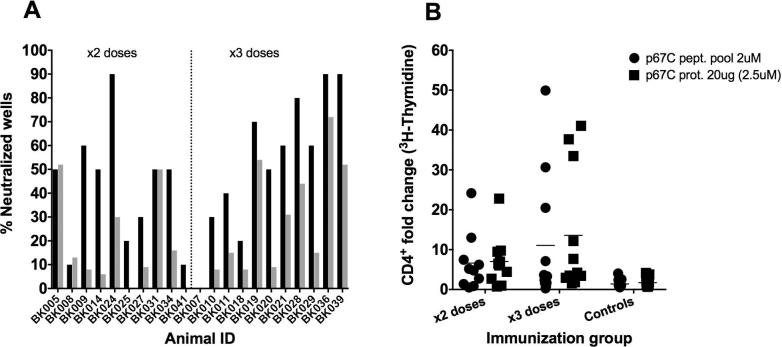
Individual antibody neutralizing capacity and p67C specific T-cell CD4+ responses. (A) Individual antibody neutralizing capacity of sera from Group 1 (2 doses) and 2 (3 doses) at day of challenge in the presence of 1% rabbit complement (black bars) or 5% heat inactivated rabbit complement (grey bars) and (B) p67C specific CD4+ T-cell proliferation index one week prior challenge (day 70) for all animal groups, measured by means of a 3H-thymidine based CD4+ proliferation assay. Two stimuli were used to measure the CD4+ proliferation: a pool of p67C overlapping 25-mer peptides at 2 μM/each and p67C protein at 20 μg/ml (equivalent to 2.5 μM). Animals are plotted individually and the average of each group of data is also present (black bar).